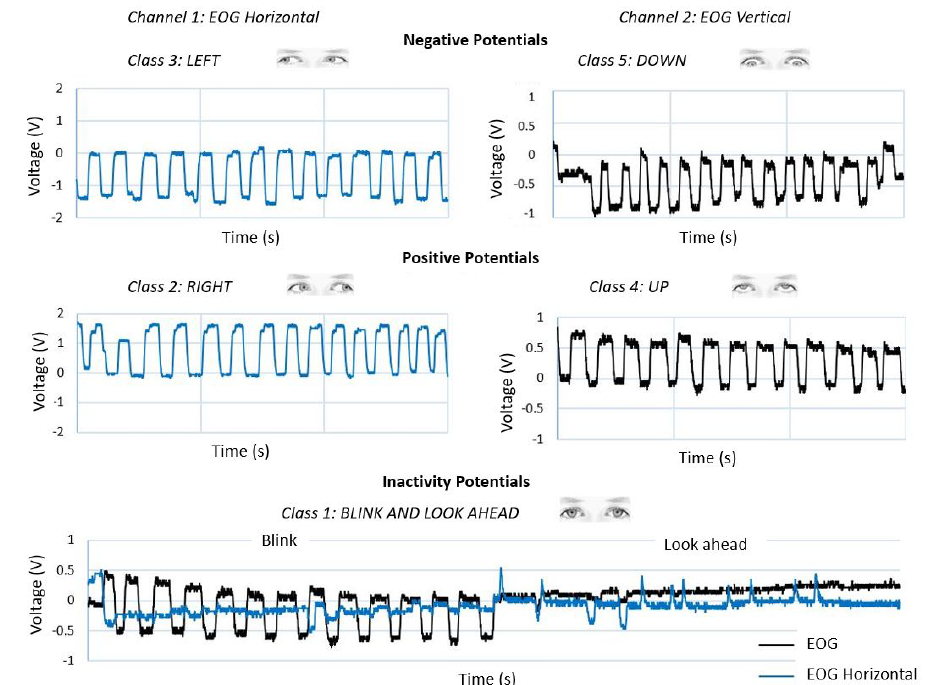
Figure 15. Graphical representation of the dataset. Horizontal and vertical EOG waveforms and the eye movement they represent; class 1: Blink and look ahead; class 2: Right; class 3: Left; class 4: Up; class 5: Down.